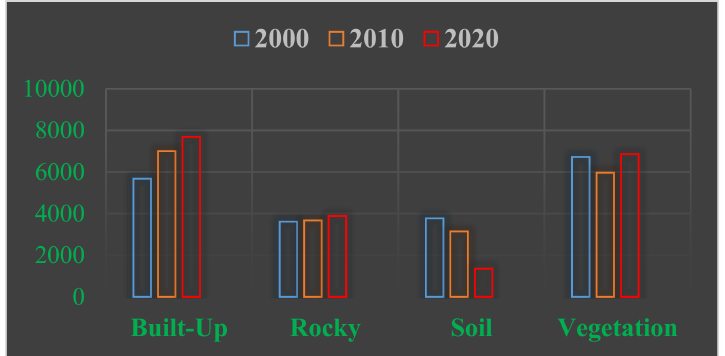
Figure 7. Land cover area (ha) of four classes at three dates provided by